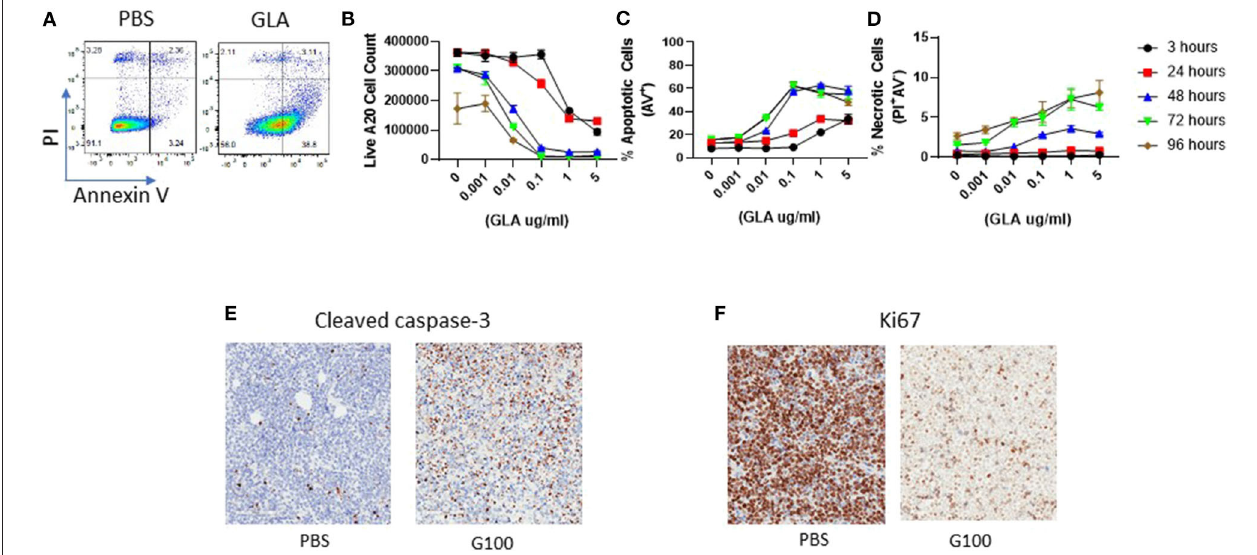
FIGURE 6 | Induction of A20 tumor cell apoptosis by GLA in vitro and in vivo . (A) Representative FACS graphs showing Annexin-V and PI staining in control or GLA-treated A20 cells. A20 cells were treated with GLA (5 µ g/mL) for 48h before staining with Annexin-V and PI. (B–D) Dose and time- dependent effect of GLA on the number of live A20 cells (B) and induction of apoptosis (C) and necrosis (D) . A20 cells were treated with serial dilutions of GLA-AF for 3, 24, 48, 72, or 96h before the cells were stained with Annexin-V/PI and analyzed by flow cytometry. Each data point represents the mean ± sem of cell number or percentage of apoptotic or necrotic cells in two replicate wells. (E,F) in vivo G100 treatment induced cleaved caspase-3, an apoptosis marker, and decreased the expression of Ki67, a proliferation marker, in A20 tumor cells. A20 tumors were collected after three intratumoral injections of G100 (10 µ g) or control PBS for IHC analysis. Brown dot indicates tumor cells that are positive for cleaved caspase-3 (E) or Ki67 (F) .